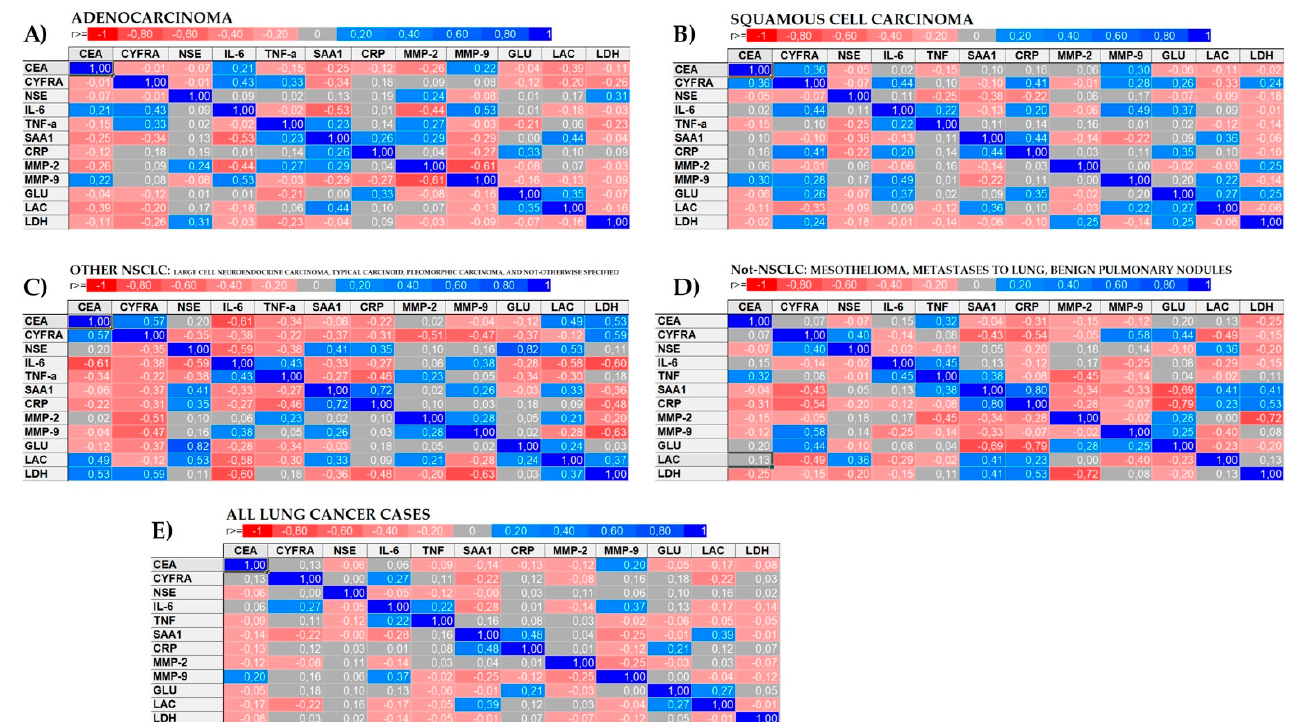
Figure 5. Heatmaps of the pairwise correlations between tumor, inflammatory, and metabolic marker concentrations in patients with ( A ) adenocarcinoma, ( B ) squamous cell carcinoma, ( C ) non-small cell lung carcinomas other than adenocarci- noma and squamous cell carcinoma, ( D ) lung neoplasms other than non-small cell lung carcinoma, and ( E ) in the entire research group without division into subgroups based on histopathological diagnosis. Correlation coefficients receive a range between − 1 (red) and 1 (blue), showing a negative and positive relationship between biomarkers, respectively. Table 6. Logistic regression analyses on the influence of confounding variables on biomarkers in distinguishing adenocarci- noma from squamous cell carcinoma patients.